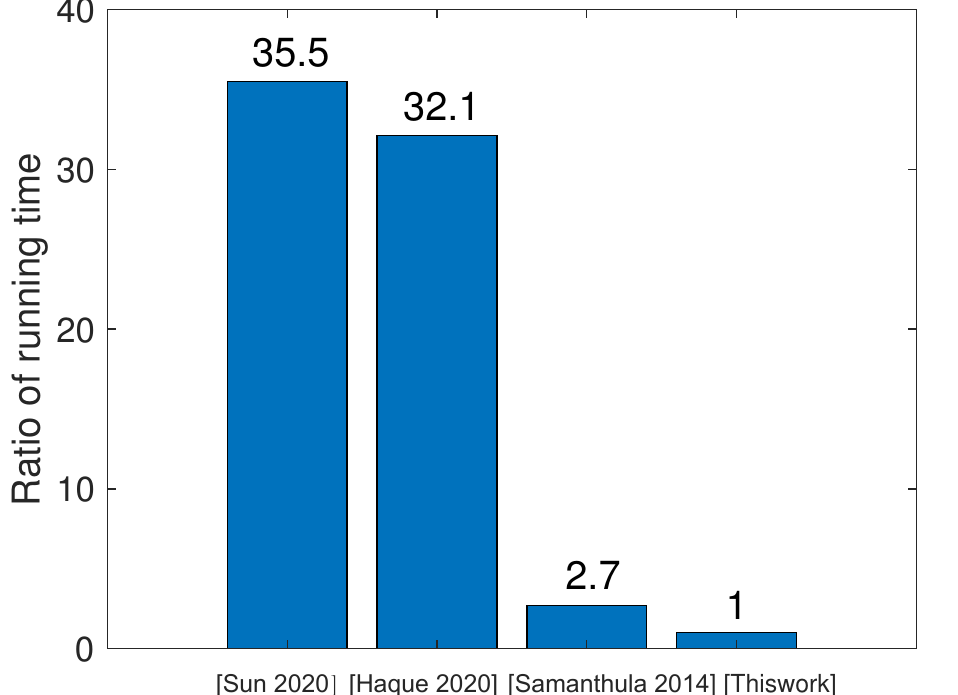
Figure 2. Running time ratio of P k NCs. Refs. [11,15,16] and [This work]